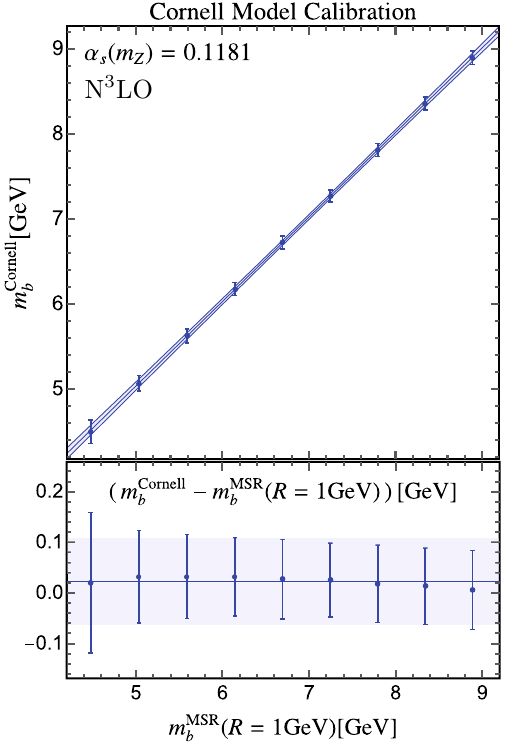
Fig. 11 Upper part of the plot: dependence of the Cornell mass param- eter with the MSR bottom mass at R = 1GeV at N 3 LO, employing the world average value for α s . Lower part of the plot: difference of the Cornell and MSR masses as a function of the latter. The error bars show the quadratic sum of fit and perturbative uncertainties. The blue line and faint blue band in the upper plot correspond to a linear fit to the points taken the individual uncertainties as uncorrelated, while in the lower plot they show the weighted average of the differences and the regular average of the uncertainties,